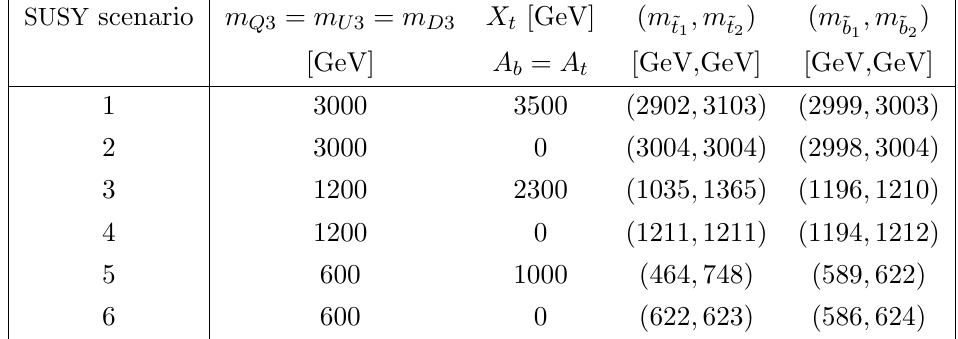
enhancement of the pseudoscalar bottom-quark Yukawa coupling g A leads to observable di(cid:11)erences also at high values of tan (cid:12) despite the fact that g Ah vanishes, i.e. decoupling is reached. We note that for this example we did not include (cid:1) b